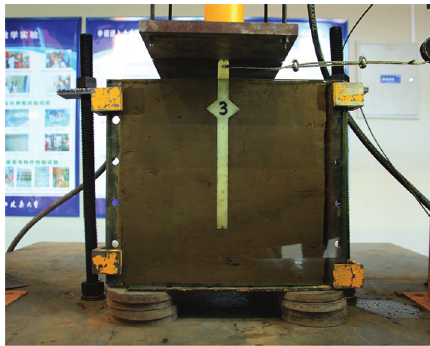
Figure 13: Installing tempered glass.